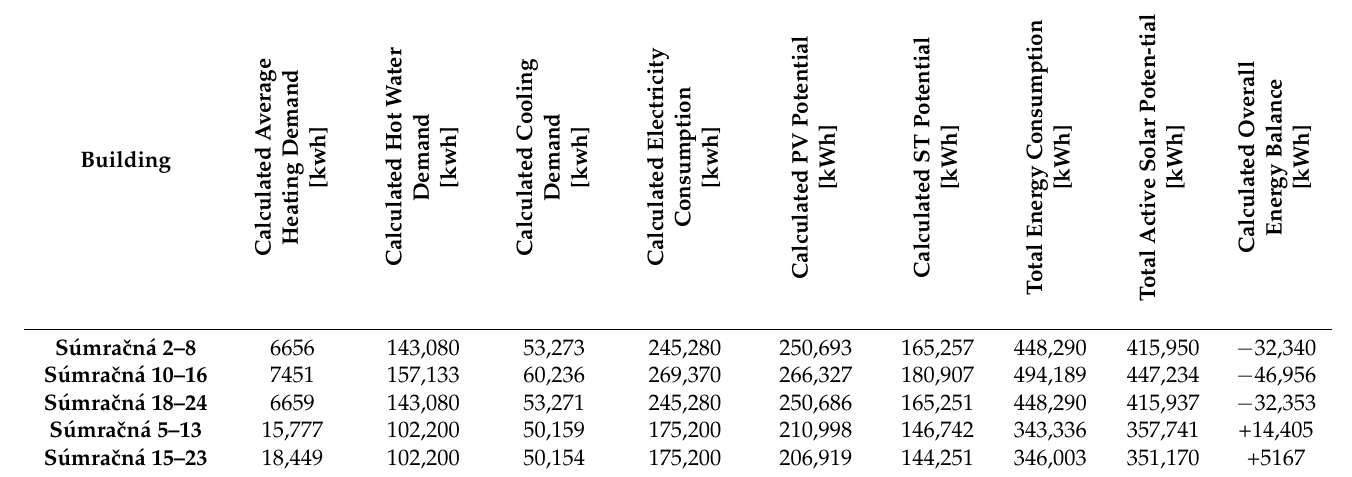
Table 5. Overview of the calculated energy demands and potentials of five residential buildings in the Ostredky housing estate, Bratislava in the event of a deep renovation. The calculated overall energy balance shows the coverage of more than 90% of the energy needs of S ú mraˇcn á 2–8, S ú mraˇcn á 10–16, and S ú mraˇcn á 18–24, and exceeds the total energy demands of buildings S ú mraˇcn á 5–13 and S ú mraˇcn á